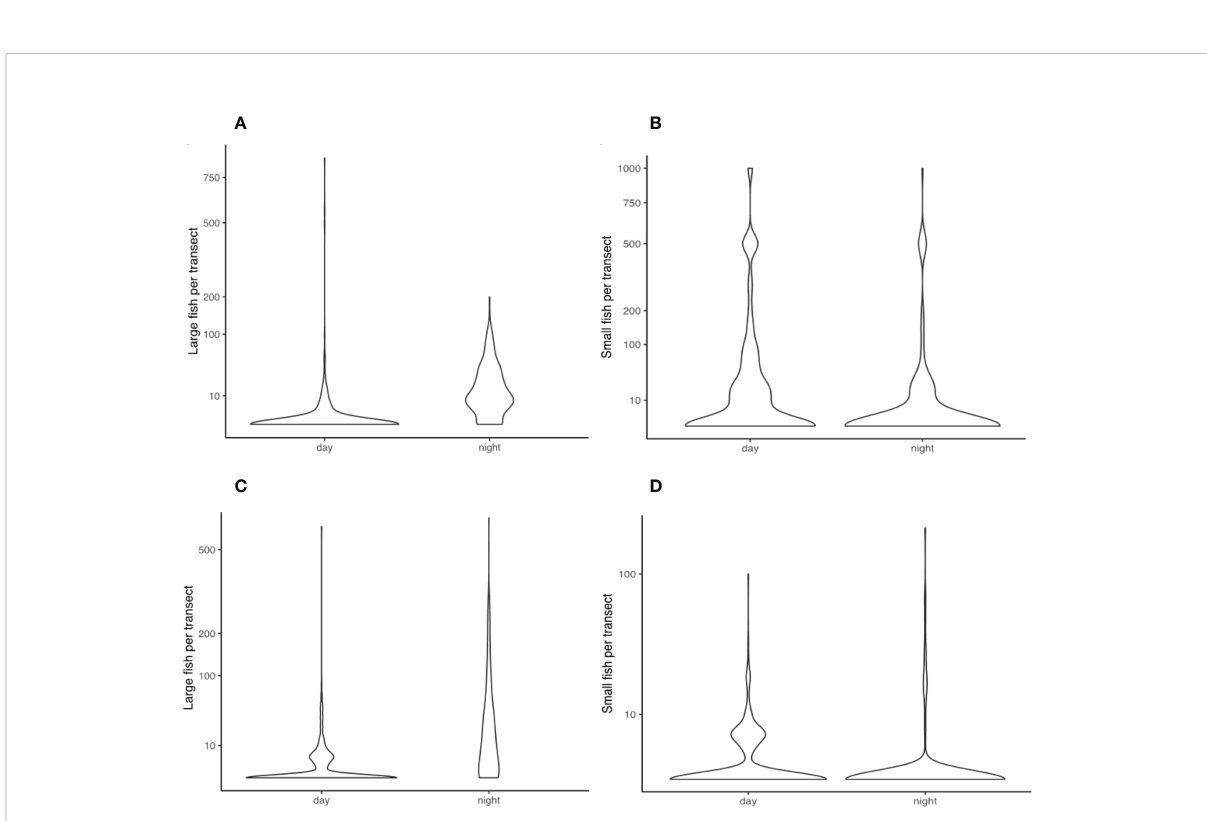
FIGURE 4 Violin distribution plots comparing the number of large fi sh (A) and small fi sh (B) recorded in sonar segments between day and night, fromMackay Harbour, and large fi sh (C) and small fi sh (D) recorded in sonar segments between day and night, from Pioneer